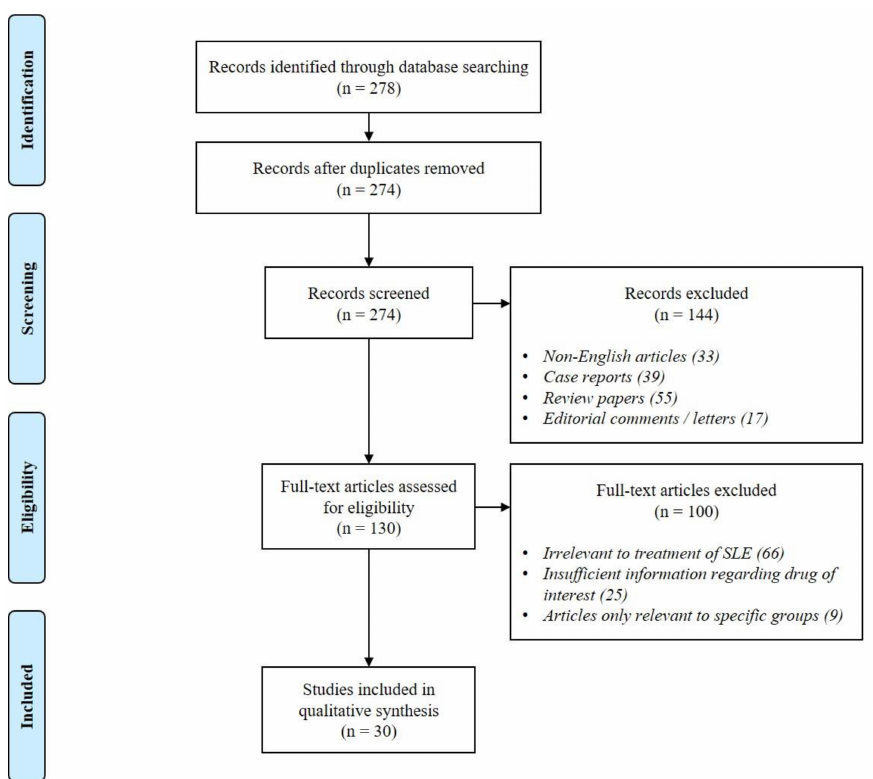
Figure 1. Summary of literature